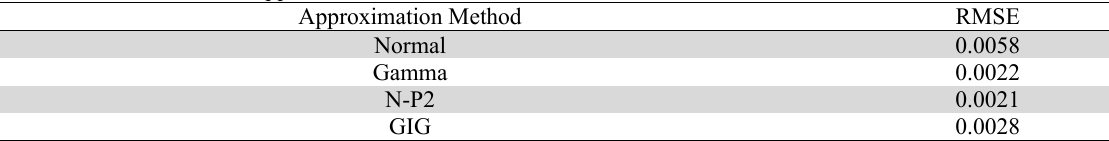
The RMSE Values of Each Approximation Method Approximation Method RMSE Normal 0.0058 Gamma 0.0022 N-P2 0.0021 GIG 0.0028